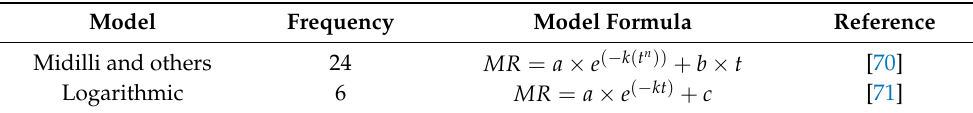
Table 2. The mathematical models fitted best the celeriac slices drying kinetics.